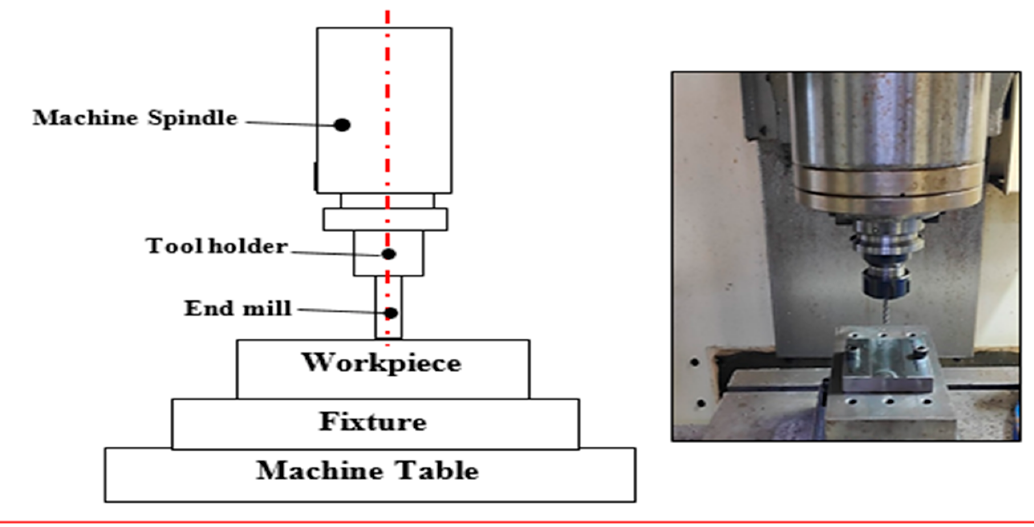
Figure 3. Experimental setup details.